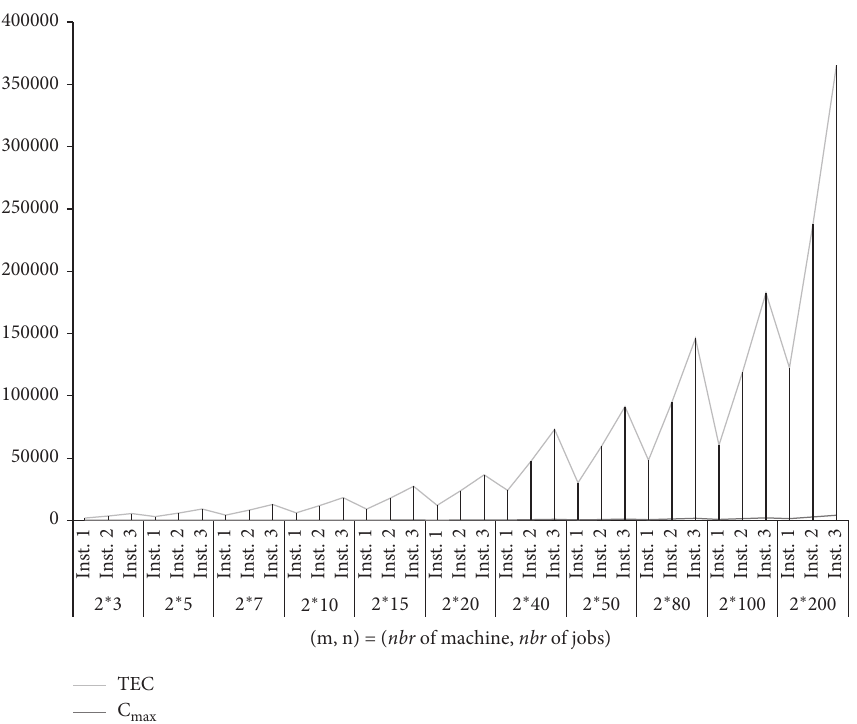
Figure 4: Evolution of the total energy consumption and the makespan, depending on the instances.